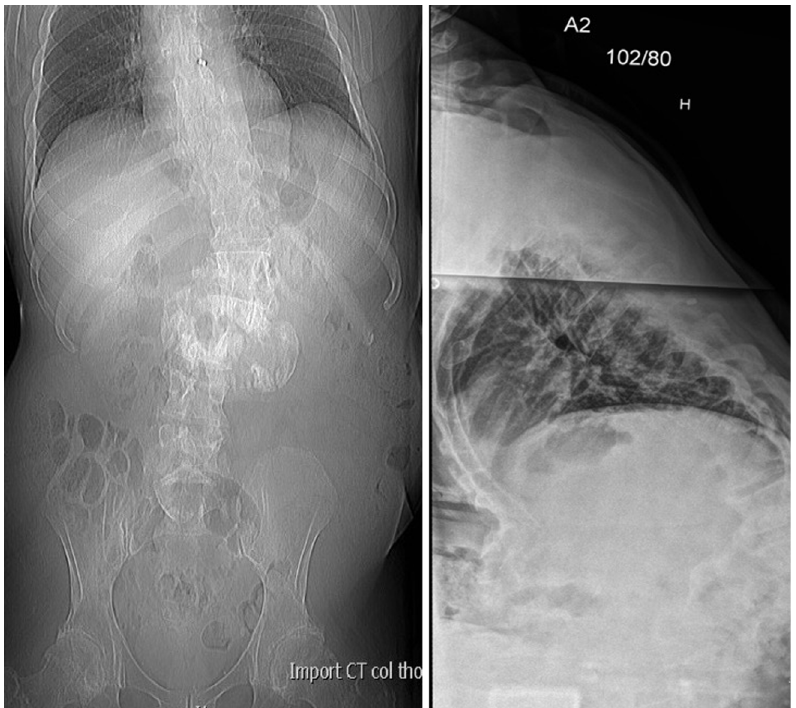
Figure 1. Radiographs showing marked destruction of L2 and L3 vertebrae with paravertebral hypertrophic ossi fi cation and kypho- scoliotic